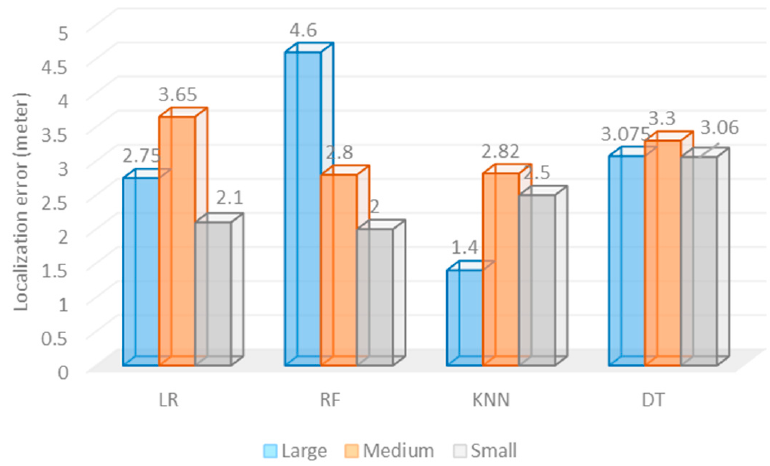
Figure 13. Average localization error for 4 localization methods using the 3 RSS datasets. Table 11. Average localization error (in meters) for the 4 tailored ML models using 3 different datasets.